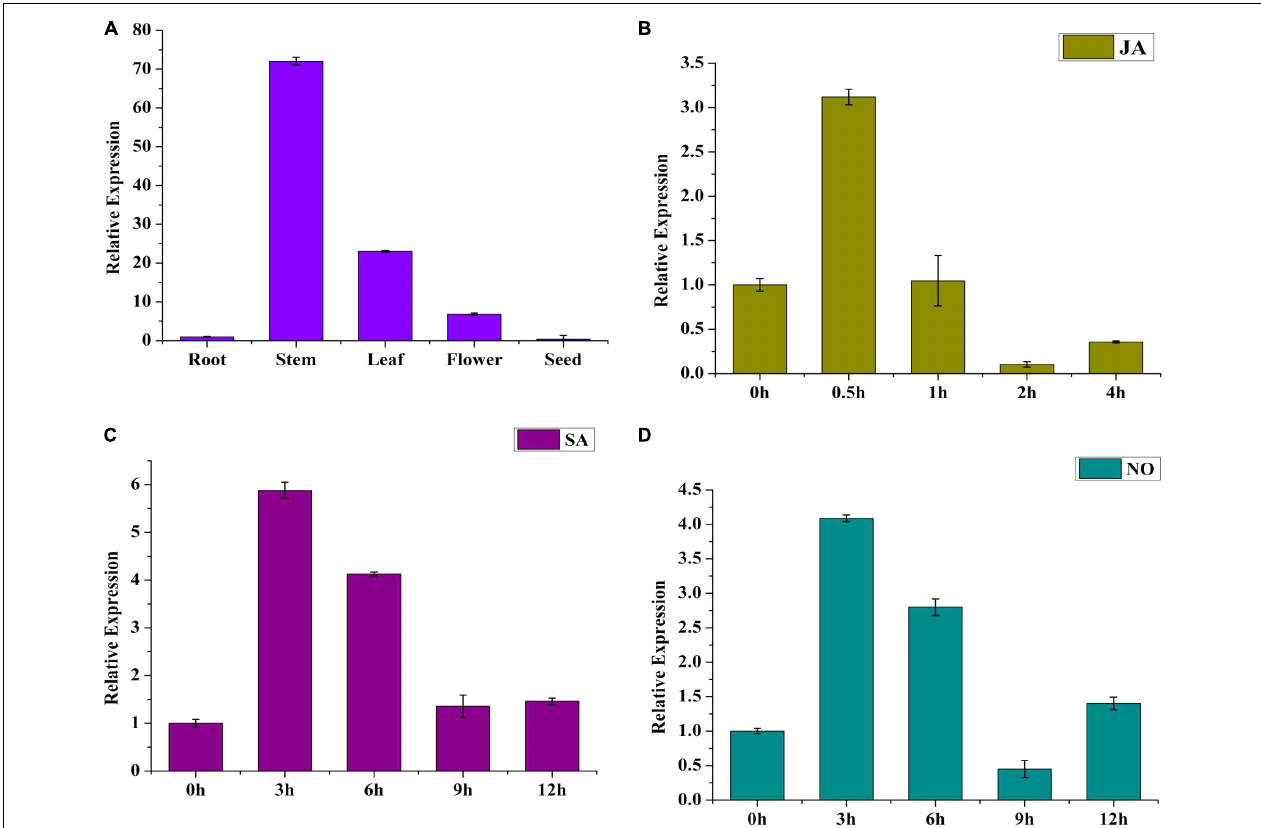
FIGURE 2 | (A) Expression pattern of SmWRKY1 in different tissues. Each tissue was obtained from several individual 2-year-old S. miltiorrhiza plants in nature. Transcript abundance of SmWRKY1 is normalized to actin by the method of 2 − (cid:49)(cid:49) Ct . (B) Time course of the expression level of SmWRKY1 after SA treatment as determined by qRT-PCR. (C) The expression level of SmWRKY1 after SA treatment for selected time points measured by qRT-PCR. (D) The expression level of SmWRKY1 after NO treatment for selected points by qRT-PCR analysis, respectively. Values are means ± standard deviation of triplicate analyses.